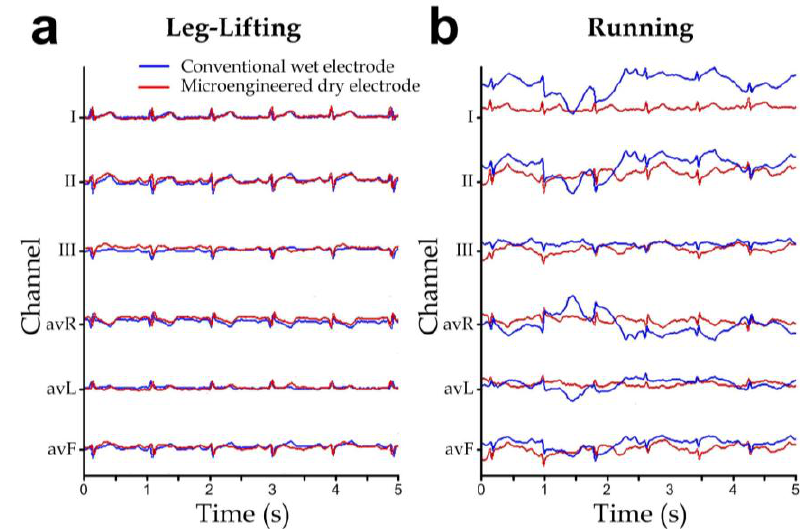
Figure 9. ECG signals simultaneously measured with the conventional wet electrodes ( blue ) and the microengineered electrodes ( red ) during different human motions: ( a ) Walking. ( b )